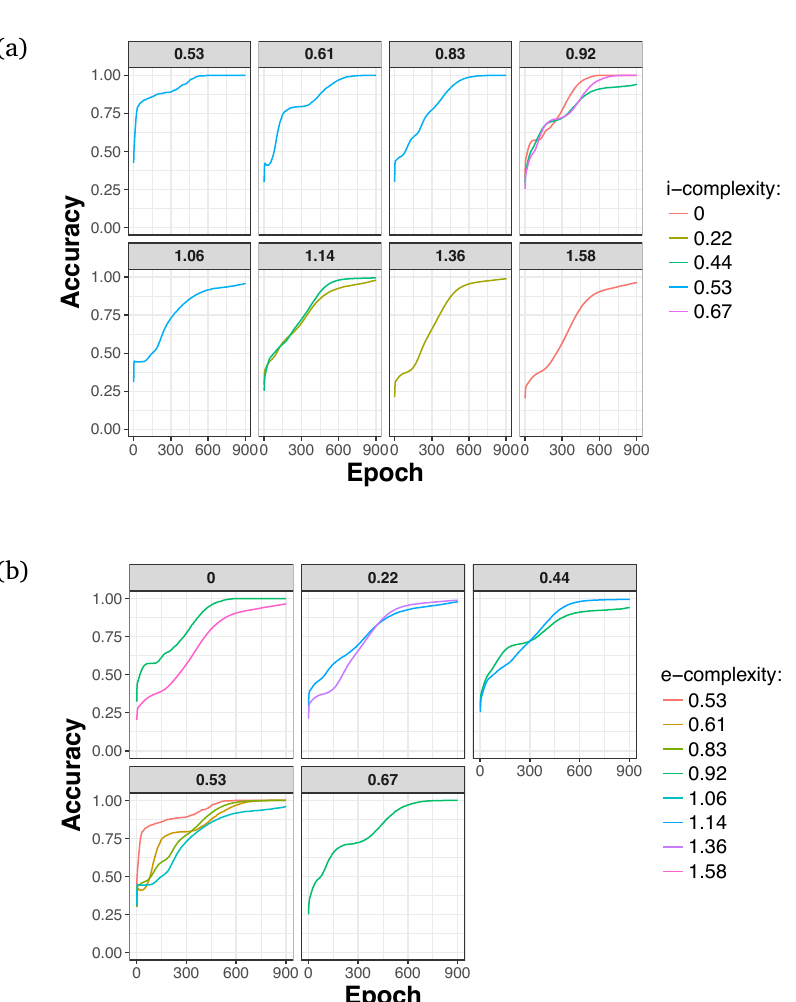
Figure 9: Network learning trajectory for paradigms varying in i-complexity and e-complexity values. (a) i-complexity varying by colour (facet titles showing e-complexity in bits). (b) e-complexity varying by colour (facet titles showing i-complexity in bits). Note that, as discussed above, for some values of e-com- plexity, the random paradigms do not vary in i-complexity. In these cases, only one learning curve is shown (e.g. for e-complexity of 0.53 bits, there are only paradigms with i-complexity of 0.53 bits). Differences in e-complexity produce higher variability in network learning trajectories (b) compared to differences in i-complexity (a)